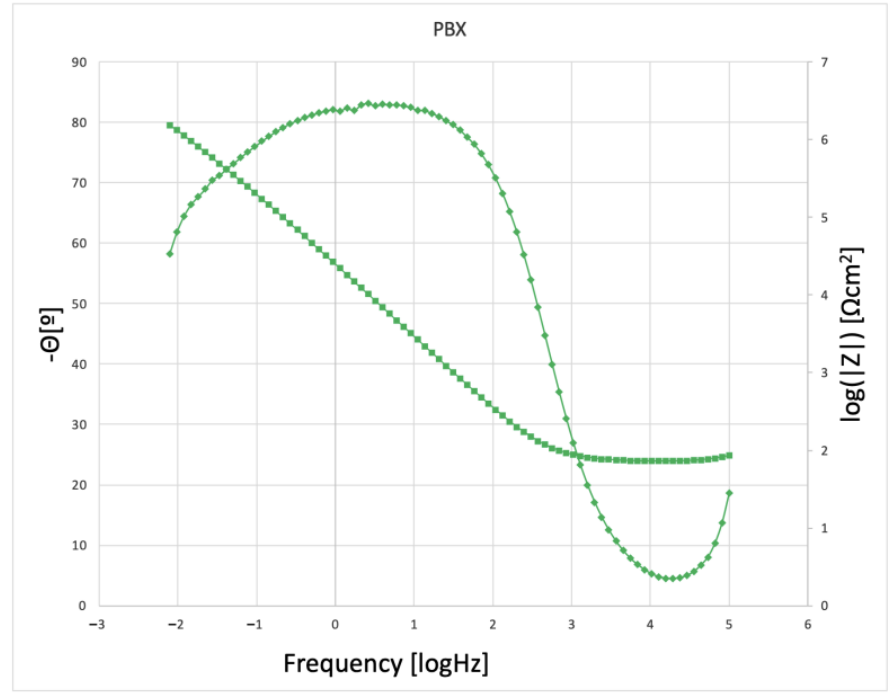
Figure 12. Bode plot for a PBX − enhanced sample .